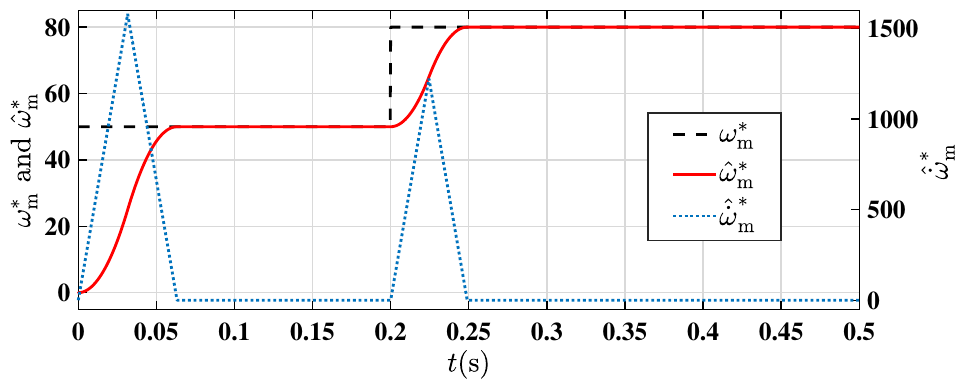
Figure 5. The reference velocity value ω ∗ m with its corresponding estimation